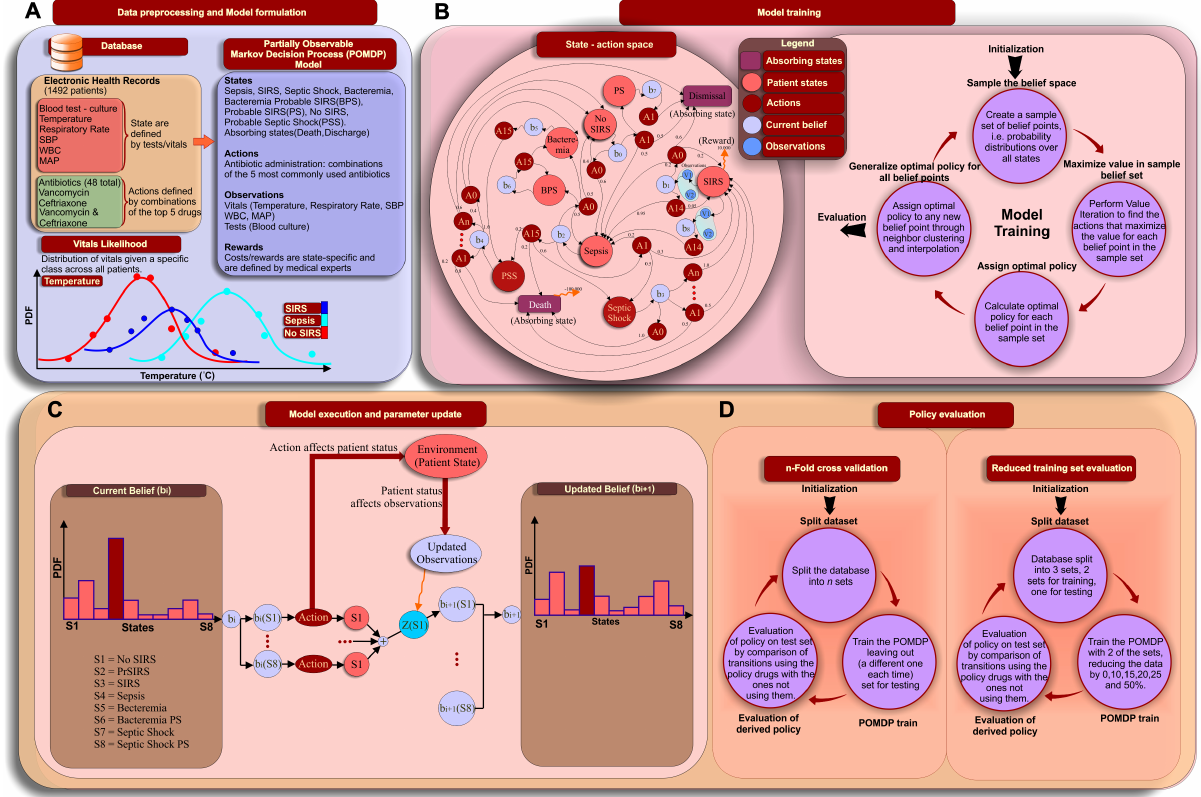
Figure 1. Development and evaluation of a clinical decision support system (CDSS) for Sepsis. (A) Synopsis of the EHR database, distribution of vitals, states, actions. Likelihood functions were used to calculate state-specific transition and observation probabilities. (B) The state-action diagram describes underlying patient states, possible transitions and beliefs based on the values of the observed variables. There are two absorbing states, “Death” and “Dismissal”. The training of the POMDP model that is applied on the state-action space performs value iteration updates on a sample set of beliefs, effectively using a Monte Carlo approach for sampling together with dynamic programming for the calculation of the value iteration. (C) Belief (ie, probability distribution of the patient states) is updated based on the action taken and the new observations. At each time step patient vitals are observed and the action that corresponds to the optimal policy is taken. A new set of observations (vitals, tests) will lead to an updated belief that may lead to a new action to be undertaken. The update is asynchronous, as it is calculated on-the-fly as new information arrives. (D) Evaluation of the CDSS framework was performed through 5-fold cross validation and data size sensitivity